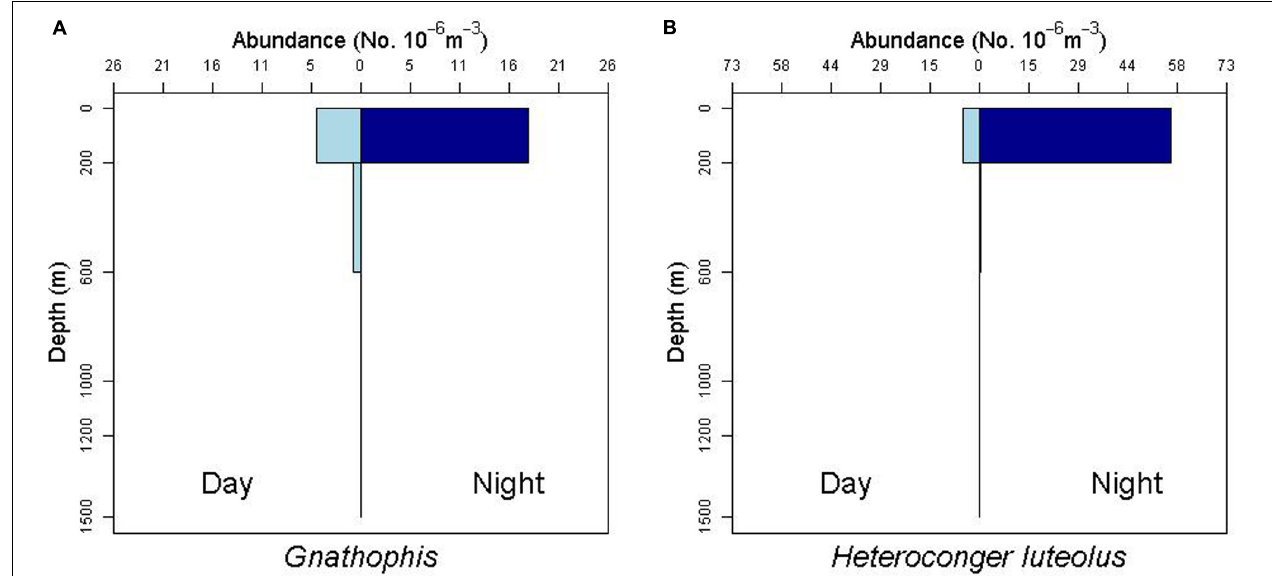
FIGURE 5 | Depth profiles for the congrid leptocephalus morphotype Gnathophis sp. and the congrid species Heterconger luteolus . Note the greater abundances at night in the surface stratum (0–200 m) as an indication of possible net avoidance by these taxa during the day.